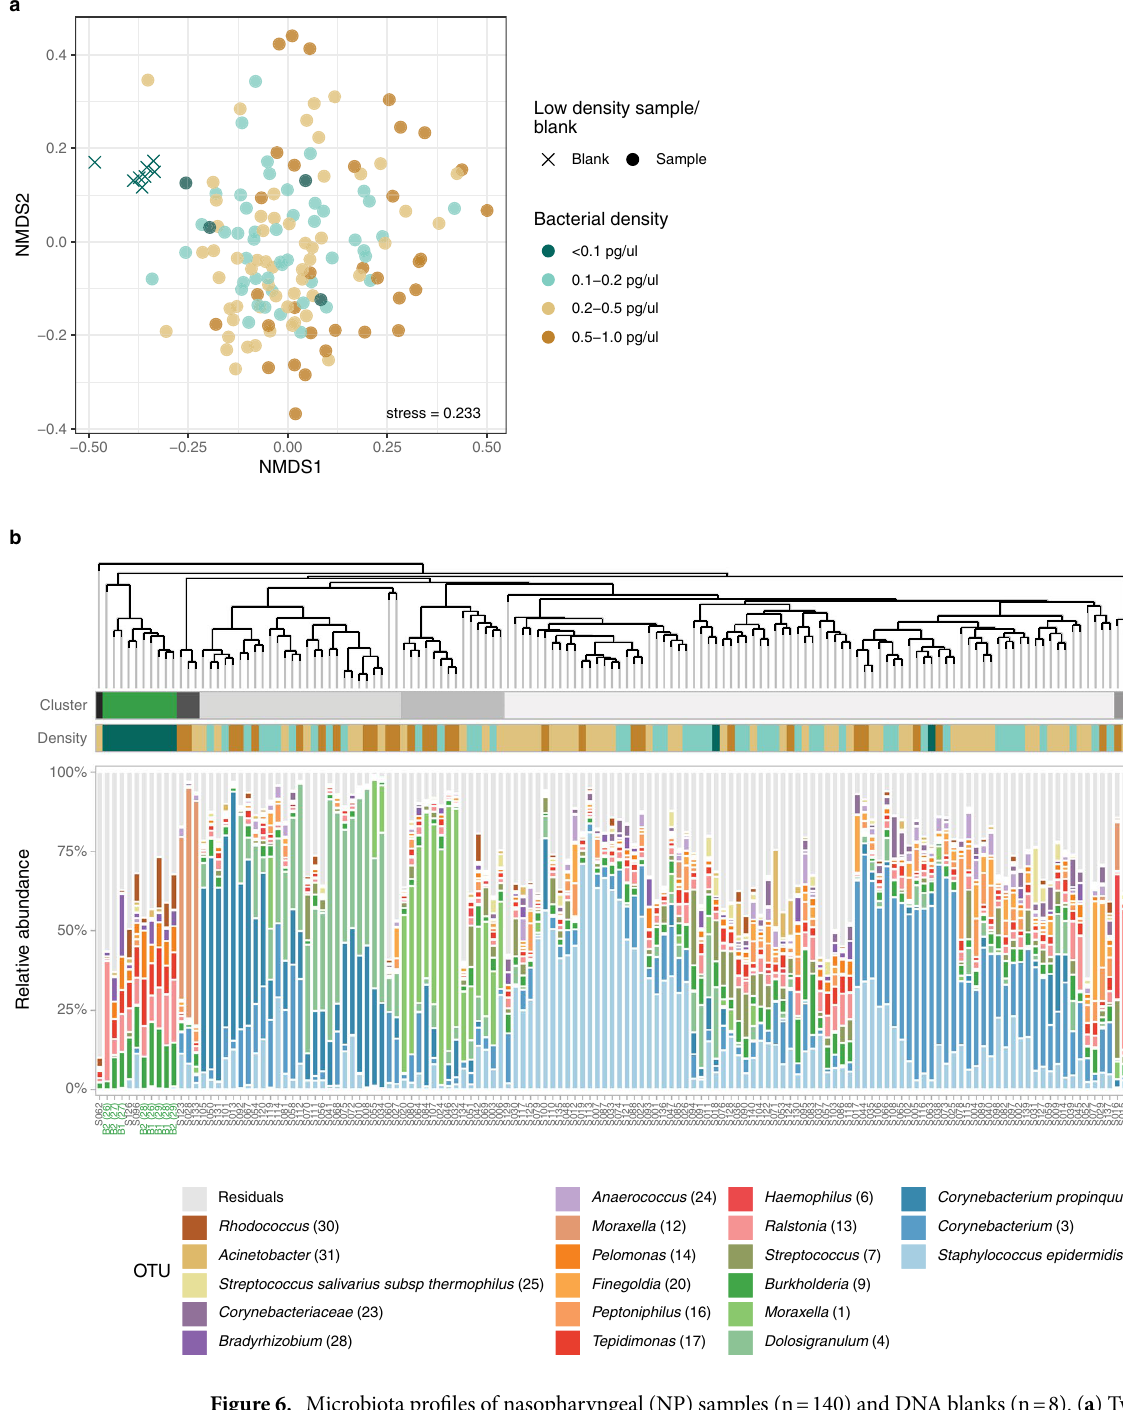
Figure 6. Microbiota profiles of nasopharyngeal (NP) samples (n = 140) and DNA blanks (n = 8). ( a ) Two- dimensional nonmetric multidimensional scaling (NMDS) plot, based on the Bray–Curtis dissimilarity matrix, visualizes the microbial community composition (each point) of the NP samples and DNA blanks (cross). Samples are stratified by DNA concentration based on 16S rRNA gene qPCR quantification (concentration pg/ µl: < 0.1; 0.1–0.2; 0.2–0.5; 0.5–1.0). The stress value illustrates how well the high-dimensional data are captured in the two-dimensional space; a value of around 0.2 indicates an acceptable representation. ( b ) Dendrogram visualizes an average linkage hierarchical clustering of NP samples and DNA blanks based on the Bray–Curtis dissimilarity index. The length of the branches represents the similarities between samples and DNA blanks. Stacked bar charts show the relative abundance of the top 20 OTUs and the residuals. Based on the clustering indices, 8 clusters were identified, 7 clusters solely consisted of NP samples (grey) and one separate cluster contained all DNA blanks and 2 NP samples (in green). Bacterial density colours correspond with colours used in the NMDS